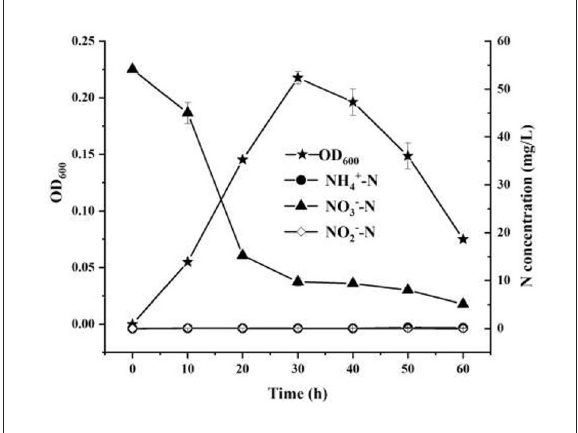
FIGURE2 The nitrate removal and cell growth performance of YC-34 strain.